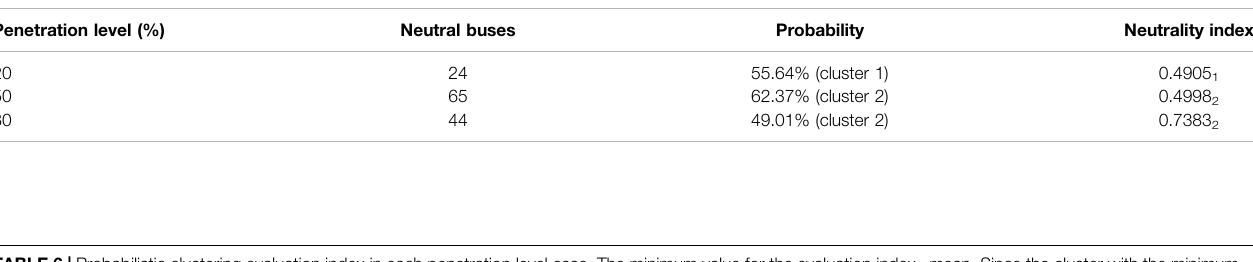
TABLE 5 | Most neutral buses in each penetration level